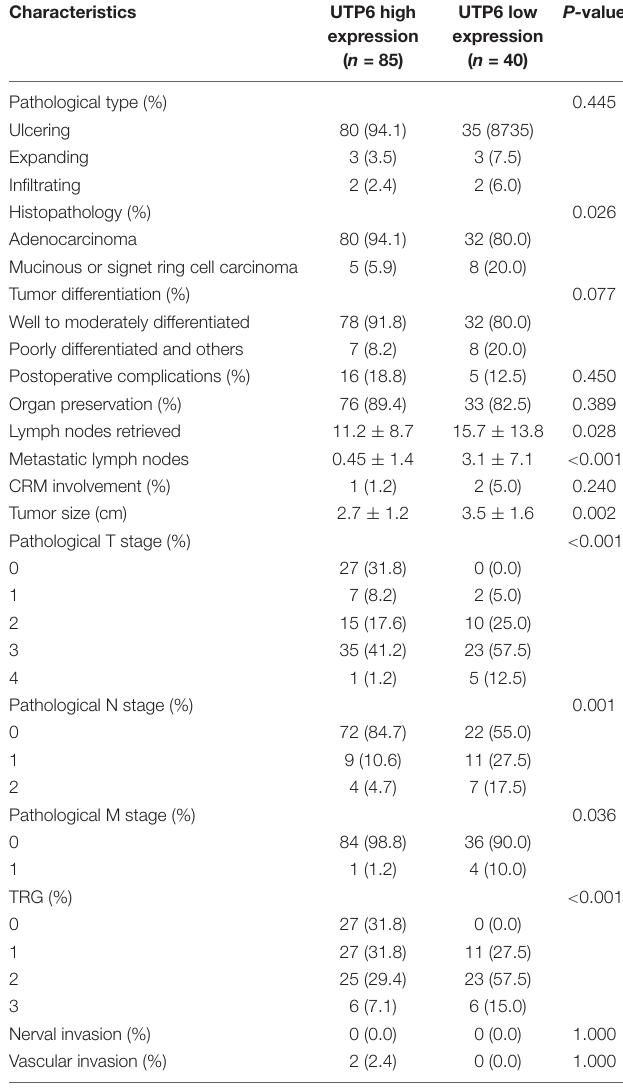
TABLE 4 | Baseline characteristics in patients with LARC following CRT stratified by UTP6 expression ( n = 125). Characteristics